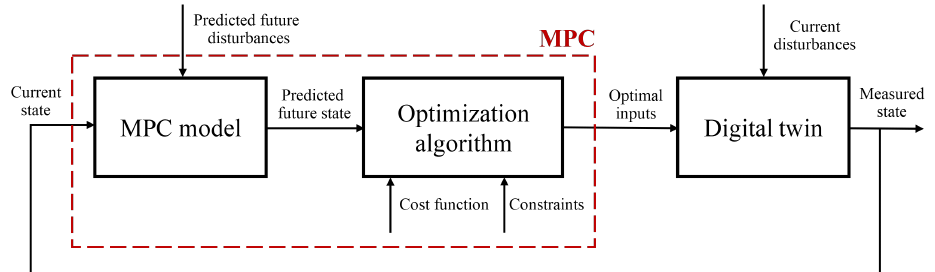
Figure 4. Schematic representation of the optimization process based on Model Predictive